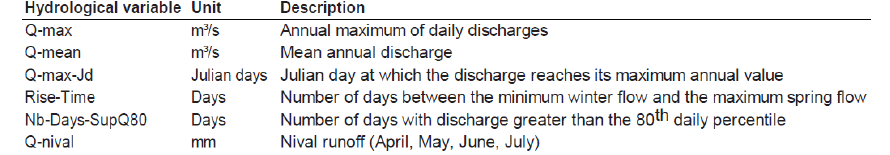
Table 1. Hydrological variables used in this paper.